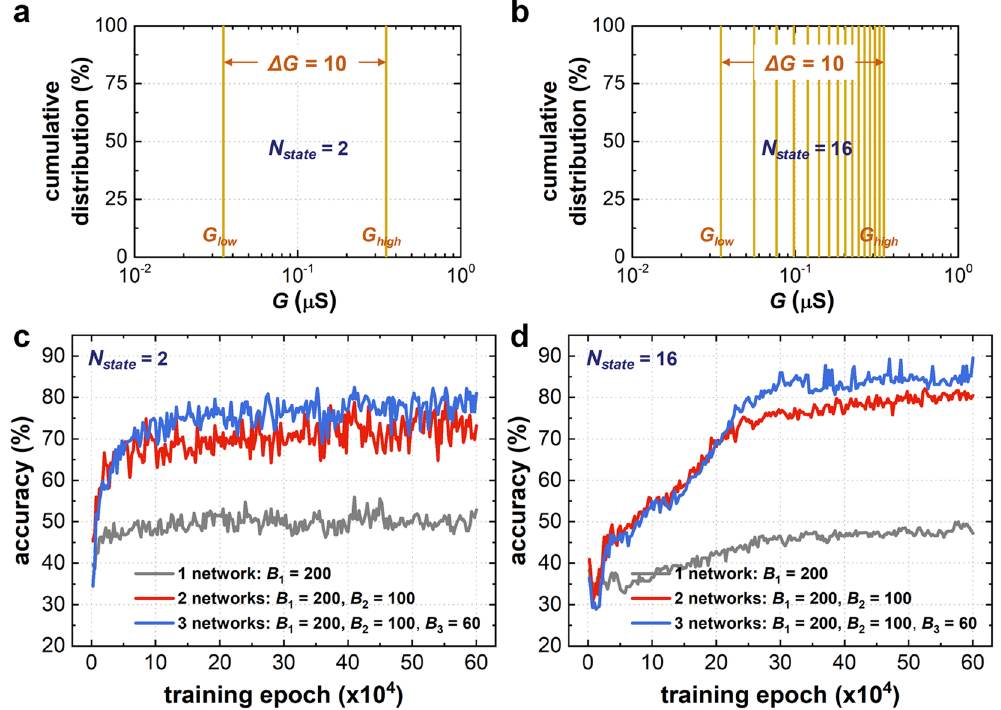
Figure 2. The distribution of synaptic device conductance ( G ) in the BNN when ( a ) N state is 2 and ( b ) N state is 16. It is assumed that there is no device-to-device variation, that is, all synaptic devices in the simulation have equivalent G high and G low values. The evolution of the classification accuracy as a function of the training epoch is shown for when ( c ) N state is 2 and ( d ) N state is 16. The simulated accuracy is obtained by repeating the simulation 10 times.